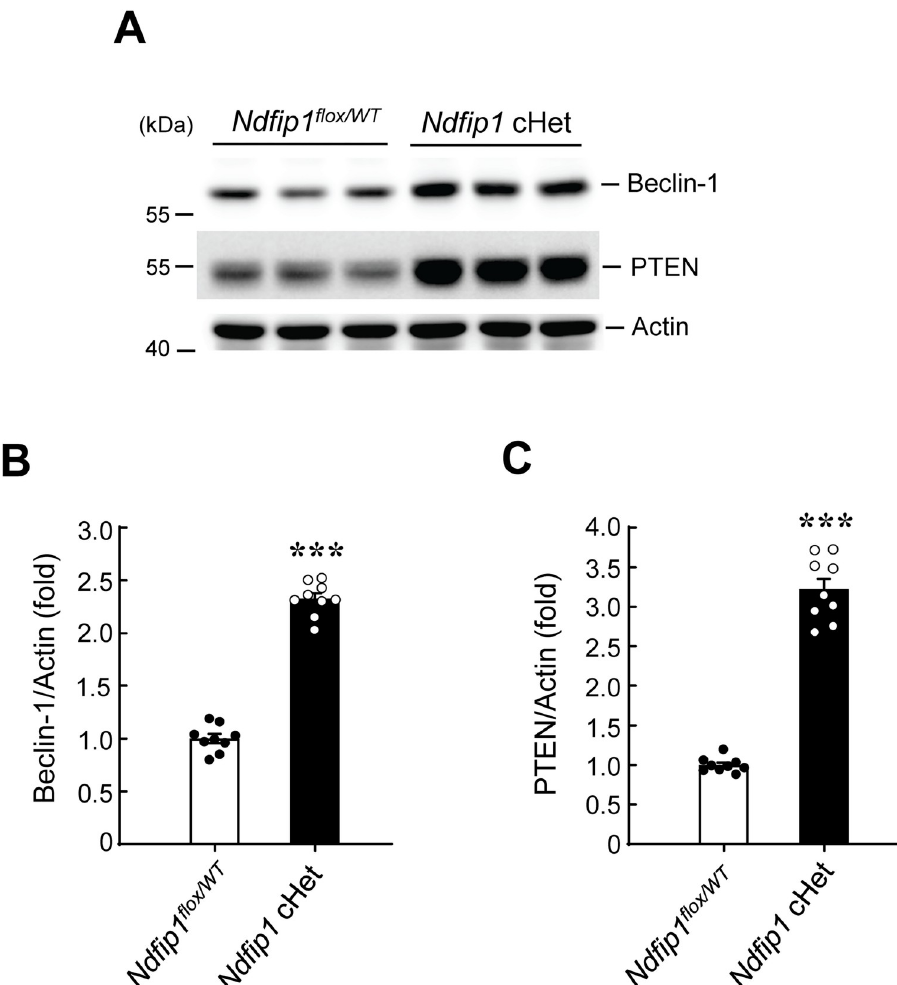
Fig 6. Beclin 1 expression and PTEN expression are increased in Ndfip1 cHet mice. (A) The CA1 tissue lysates from animals in Fig 2 (D-G) were subjected to western blot determination of Beclin 1 and PTEN expression. Both Beclin 1 and PTEN expression level is increased in Ndfip1 cHet mice than Ndfip1 flox/WT mice. (B) The quantified result of Beclin 1 expression in Ndfip1 flox/WT mice and Ndfip1 cHet mice (N = 9 each group) (t 1,16 = 19.61, p < 0.001). (C) The quantified result of PTEN expression in Ndfip1 flox/WT mice and Ndfip1 cHet mice (N = 9 each group) (t 1,16 = 16.17, p < 0.001). Data are expressed as individual values and mean ± SEM. *** p < 0.001.